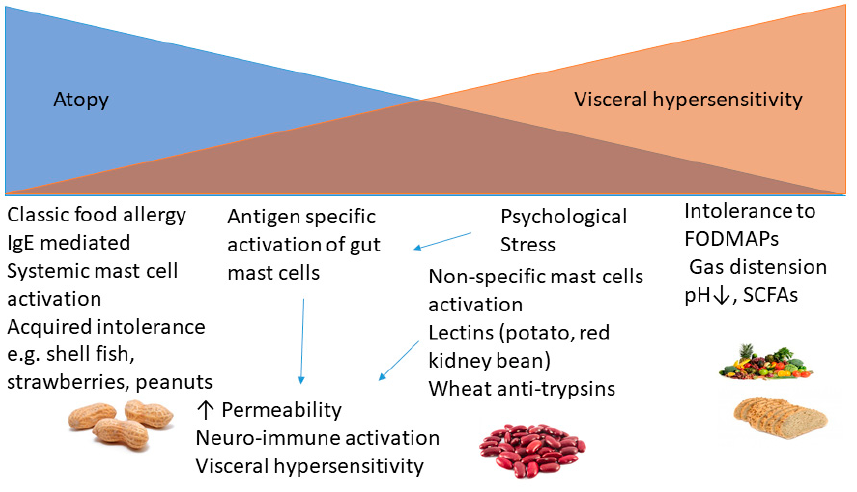
Figure 1. Immune and non-immune mechanisms underlying food intolerance in IBS.